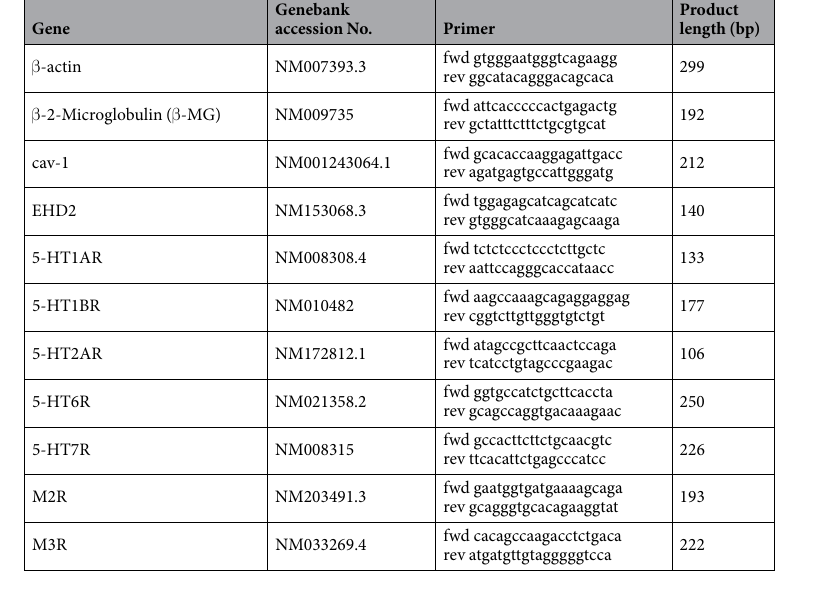
Table 1. Oligonucleotide primers for PCR